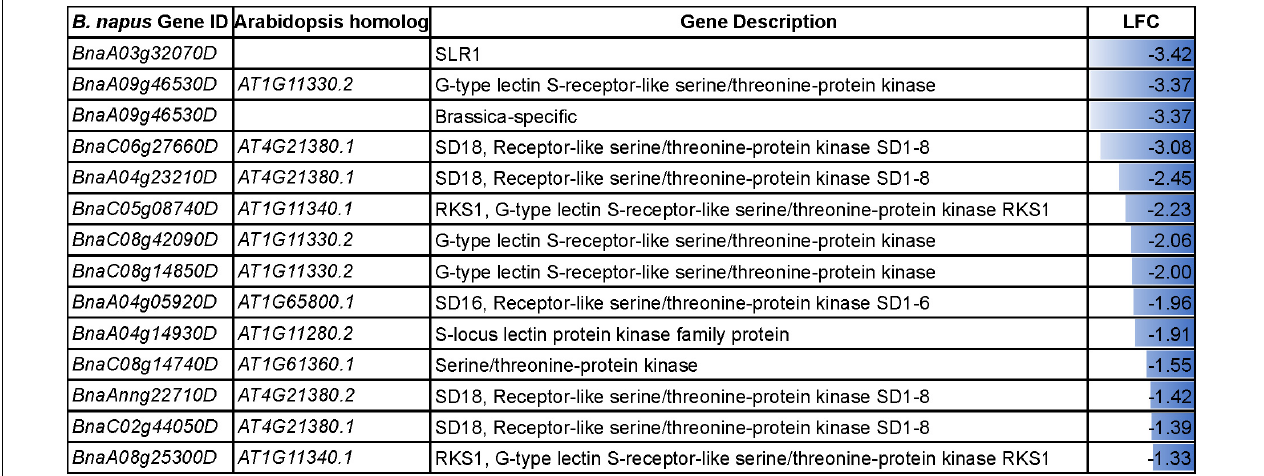
leads to accumulation of the intermediates ( Supplementary Figure S3 ) which has been suggested to result in incompatible pollen-pistil interactions (Elleman and Dickinson,